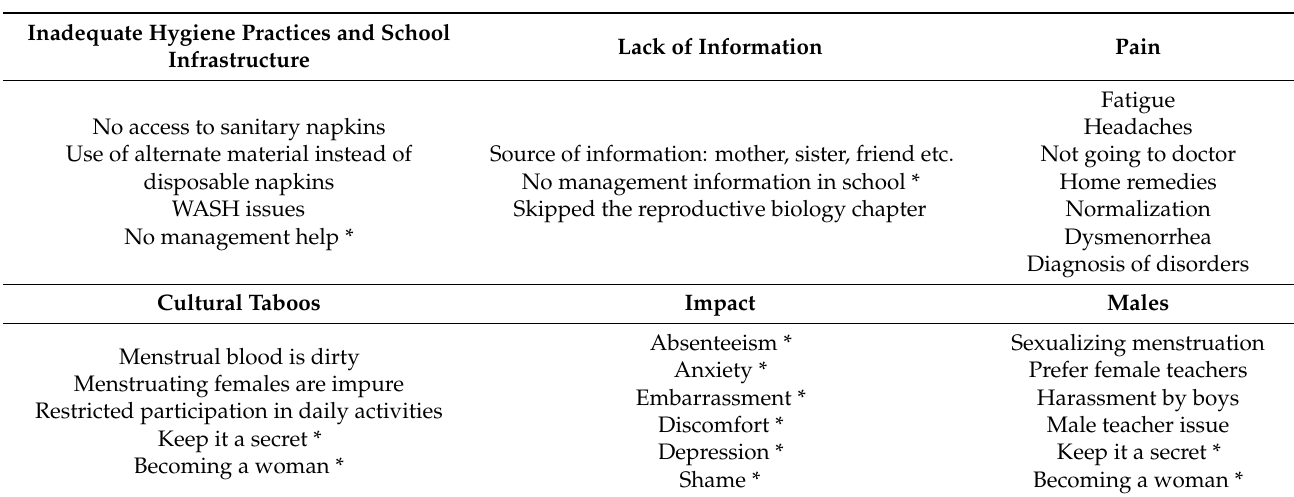
Table 1. Preliminary themes.